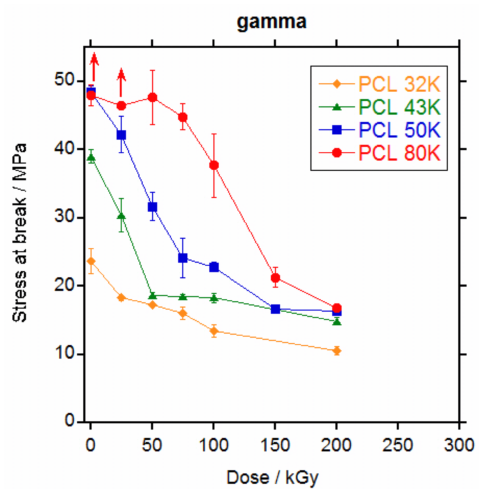
Figure 6. Stress at break values for PCL 32, 43, 50 and 80 K irradiated at different doses by electron beam (top) and by gamma rays (bottom).